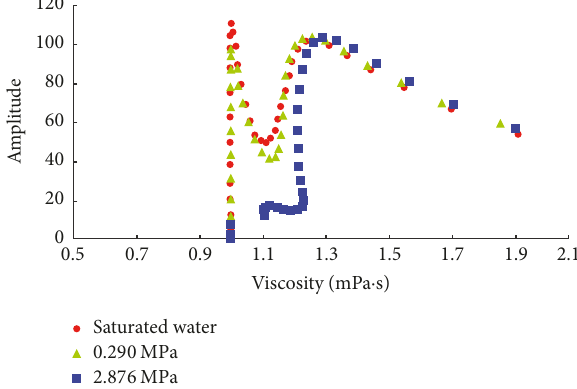
Figure 8: In situ viscosity spectrum of 0.130 mD rock sample under different displacement